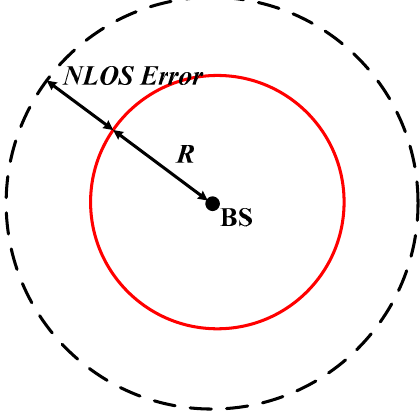
Figure 7. Example of the uniformly distributed noise model.